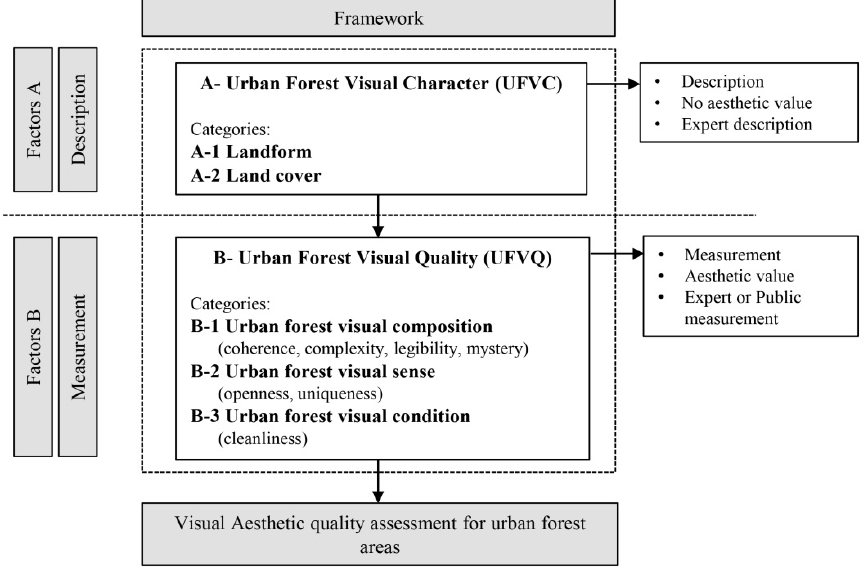
Figure 2. Integrated framework for visual aesthetic quality assessment of urban forest. Reprinted from [2].